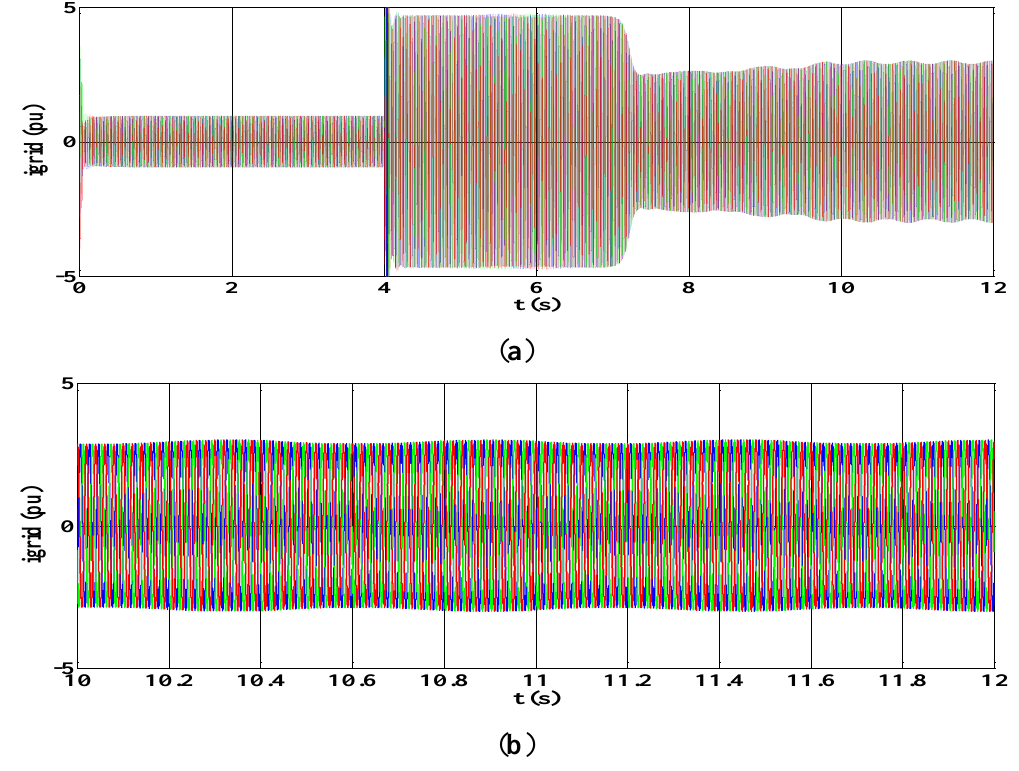
Figure 36. ( a ) Grid line currents (short-circuit happens at t = 4 s), ( b ) zoom of